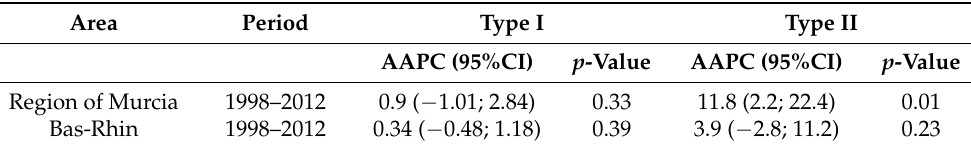
Table 4. Average annual percentage change (AAPC) in age-adjusted incidence rates (2013 European Standard Population) for type I and II endometrial carcinomas in women from the Region of Murcia and the Bas-Rhin area, 1983–2012